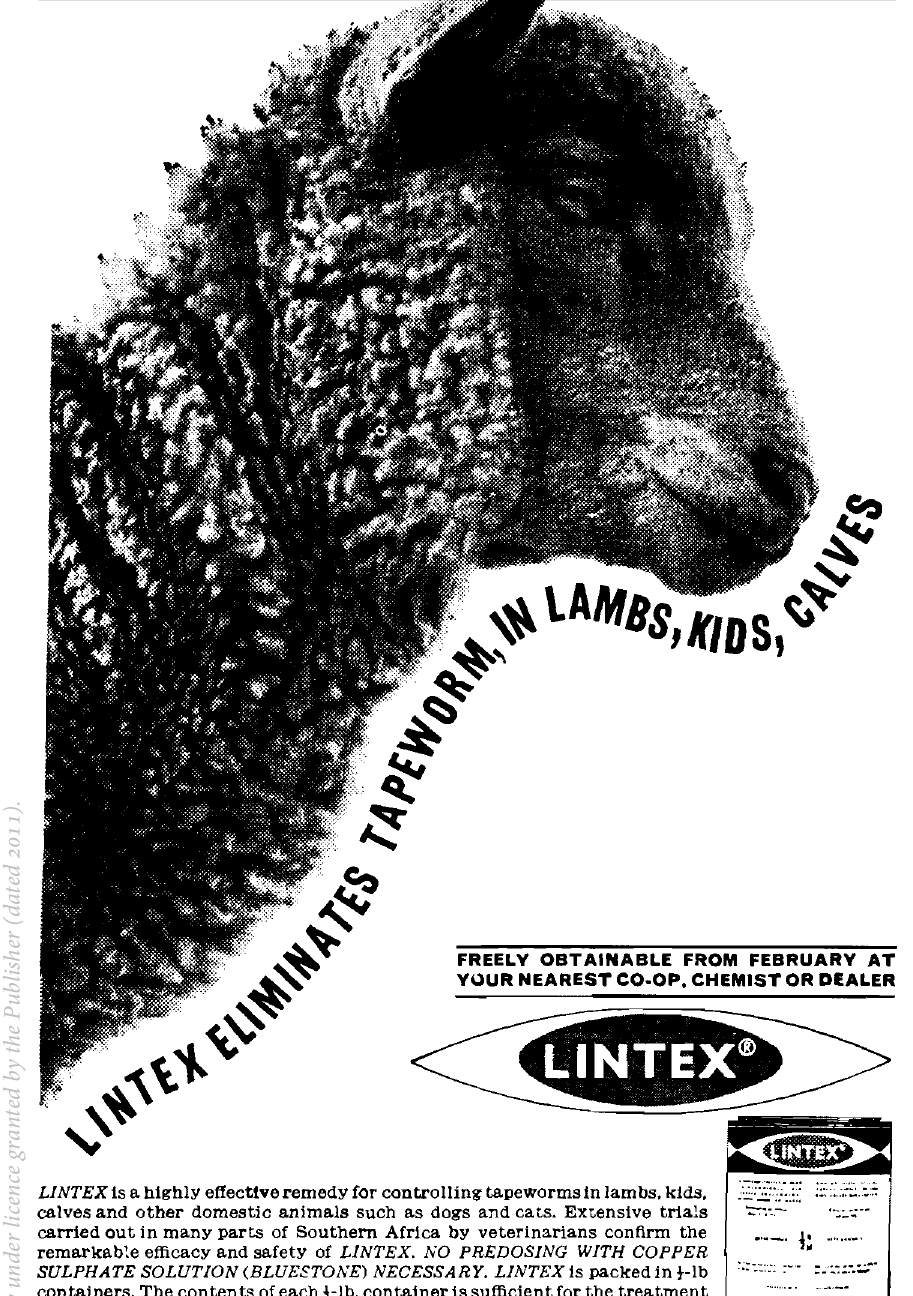
SULPHATE SOLUTION (BLUESTONE) NECESSARY. LINTEX is packed in t-lb containers. The COn ten ts of each ,-lb. container is sufficient for the trea tmen t of 188 lamts OT 62 calves. Highly effective against the immatuTe stages of the conical